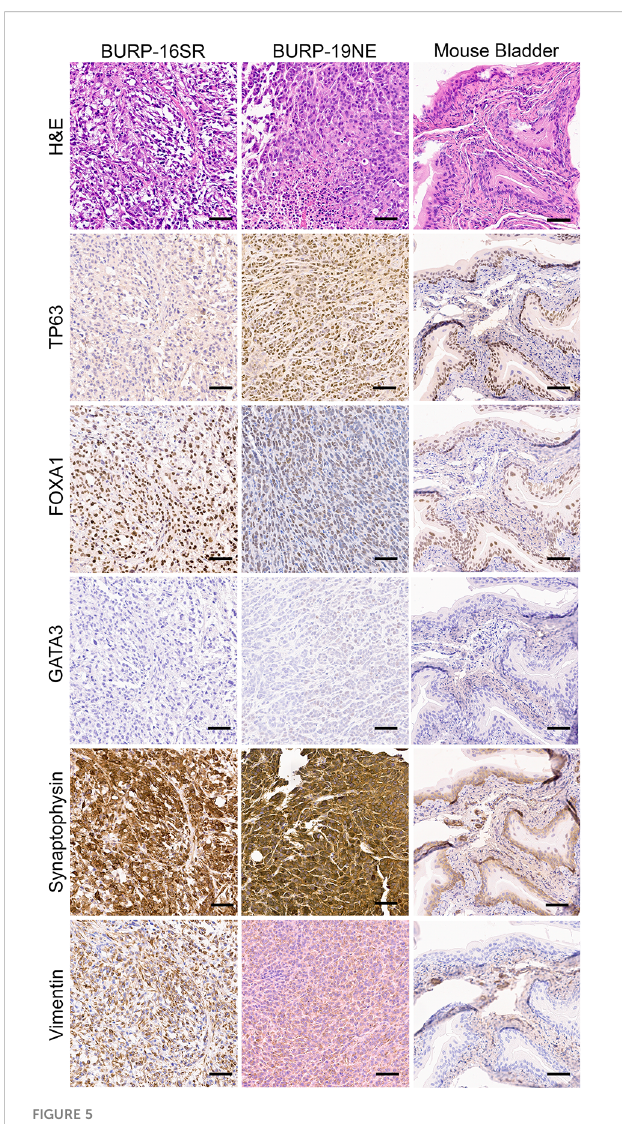
FIGURE 5 IHC of differentiation markers in the BURP-16SR and BURP-19NE lines. Serial sections were stained with H&E, TP63 IHC, FOXA1 IHC, GATA3 IHC, Synaptophysin IHC, and Vimentin IHC. Normal bladder control from BURP-16SR allograft is a control for the IHC staining. Scale bar is